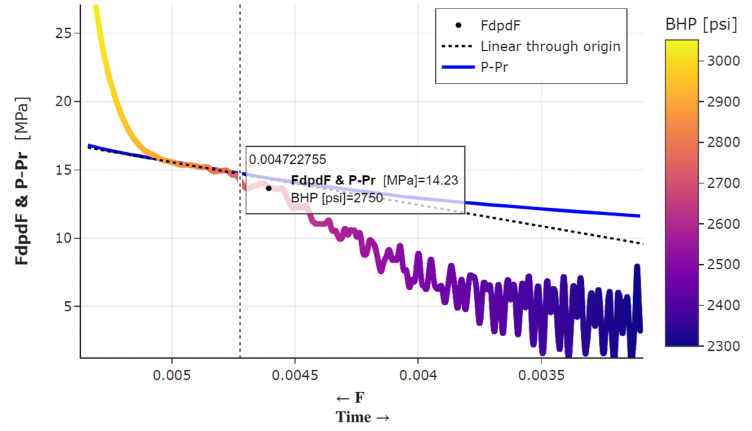
Figure 19. F-function of the shut-in test 7 cycle 2.1.